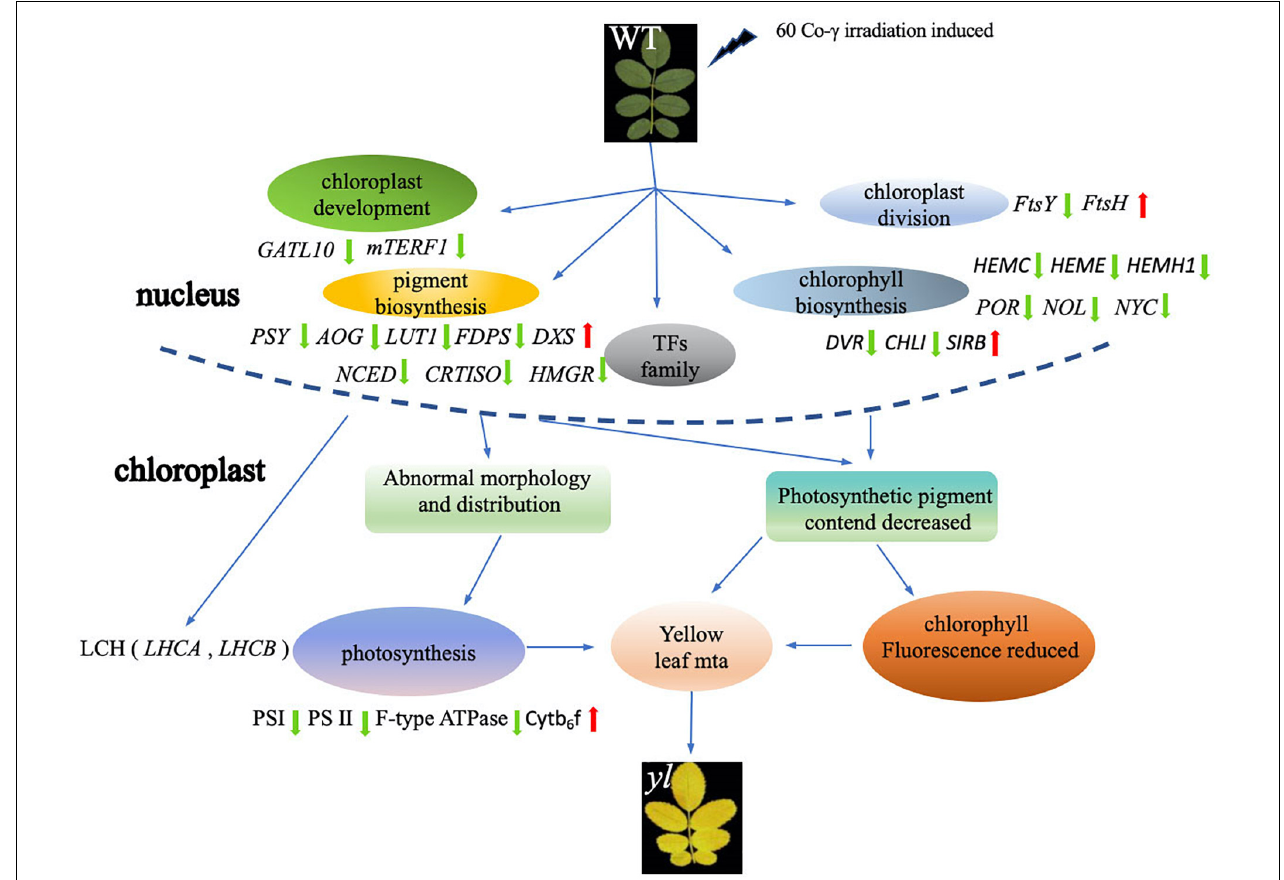
FIGURE 8 | Overview of possible formation pathway of yls of the R. beggeriana